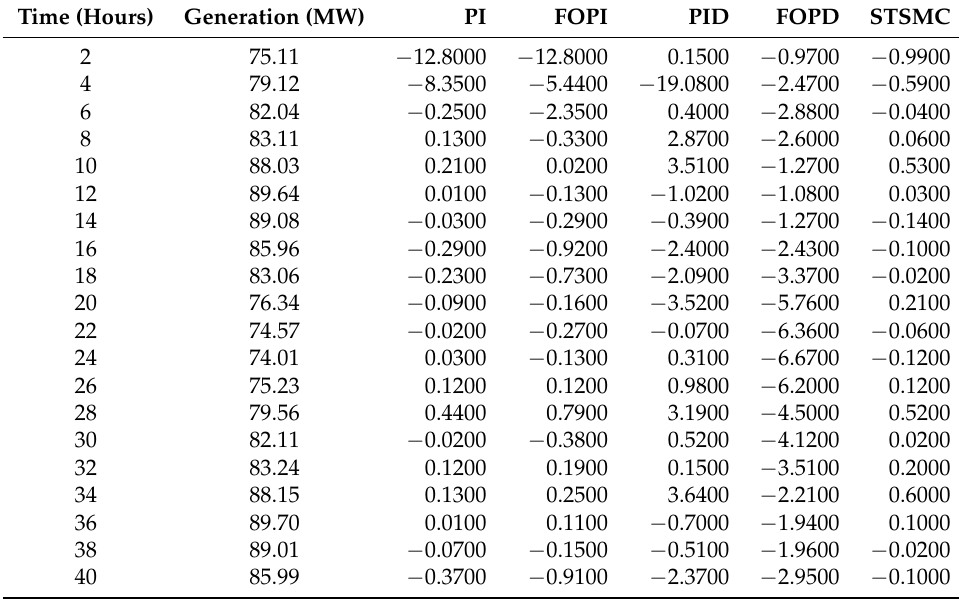
Table 4. Error comparison in tracing the generation by demand of consumer using PI [14], FOPI [43], PID [43], FOPD and